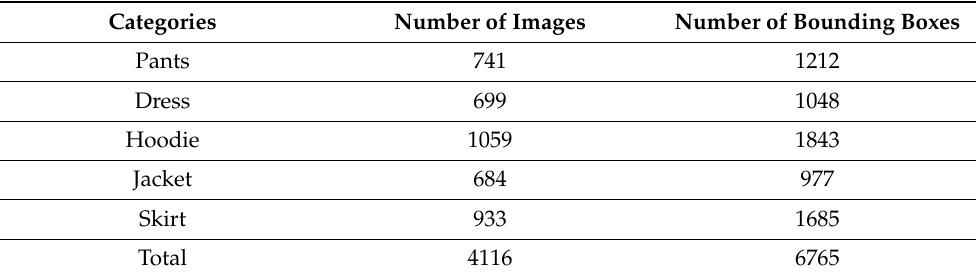
Table 1. The number of pictures and bounding boxes per category.